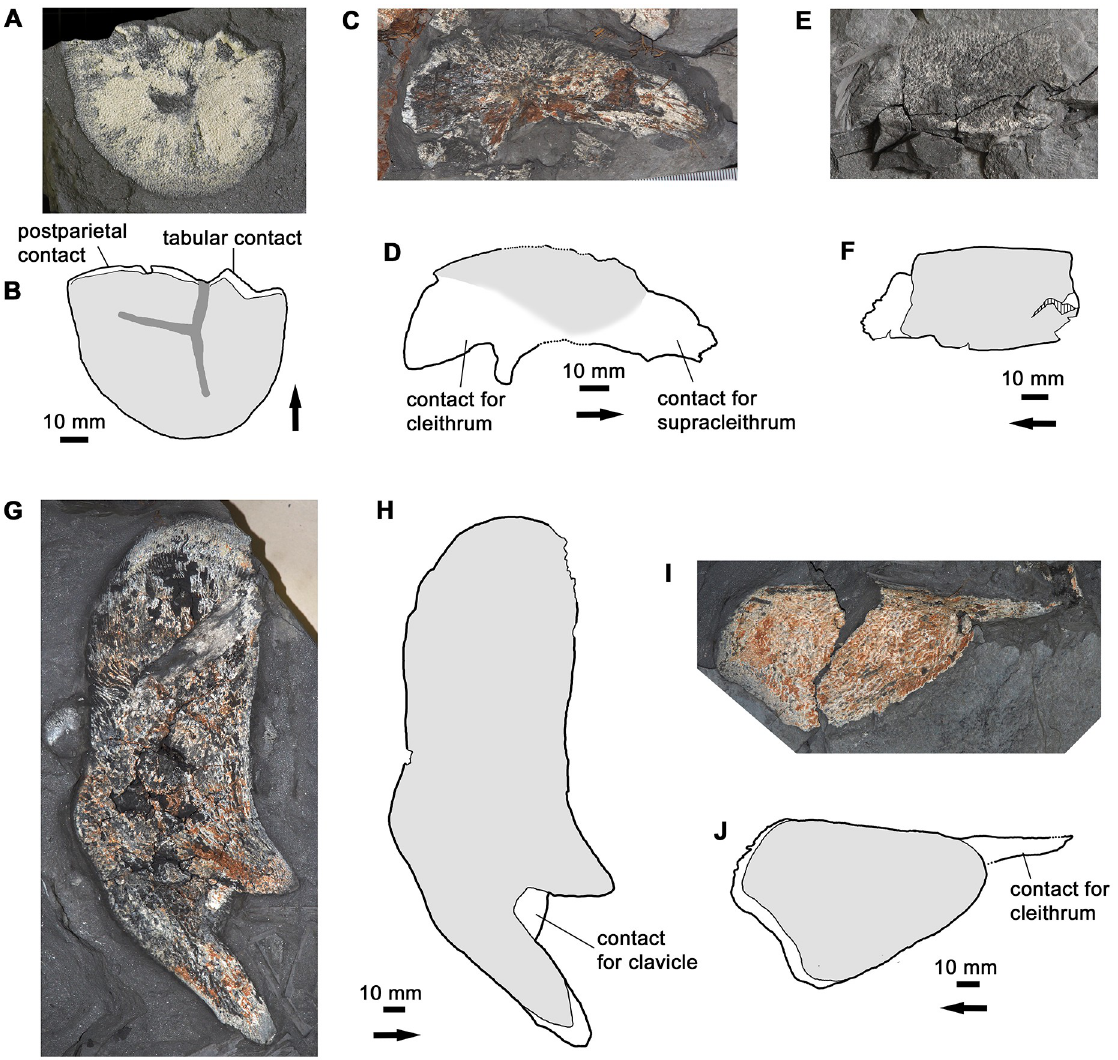
Fig 9. The pectoral girdle. A-B, photo and interpretative drawing of lateral extrascapular, AM6542b. B also includes information from counterpart. C-D, photo and interpretative drawing of anocleithrum, AM6528a. E-F, photo and interpretative drawing of possible supracleithrum (or submandibular), AM18003. G-H, photo and interpretative drawing of cleithrum, AM6540b. I-J, photo and interpretative drawing of clavicle, AM6528b. J also includes information from counterpart. Graphic conventions as in Fig 4.